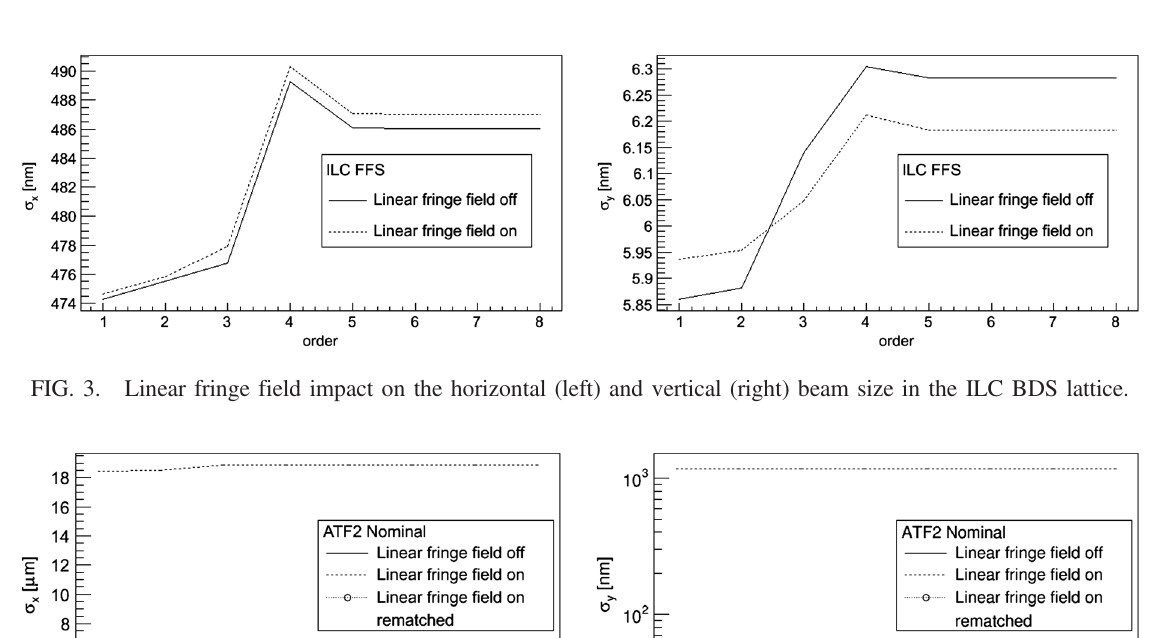
FIG. 2. Linear fringe field impact on the horizontal (left) and vertical (right) beam size in the CLIC BDS lattice. The horizontal axis stands for the polynomial order of the transfer map.